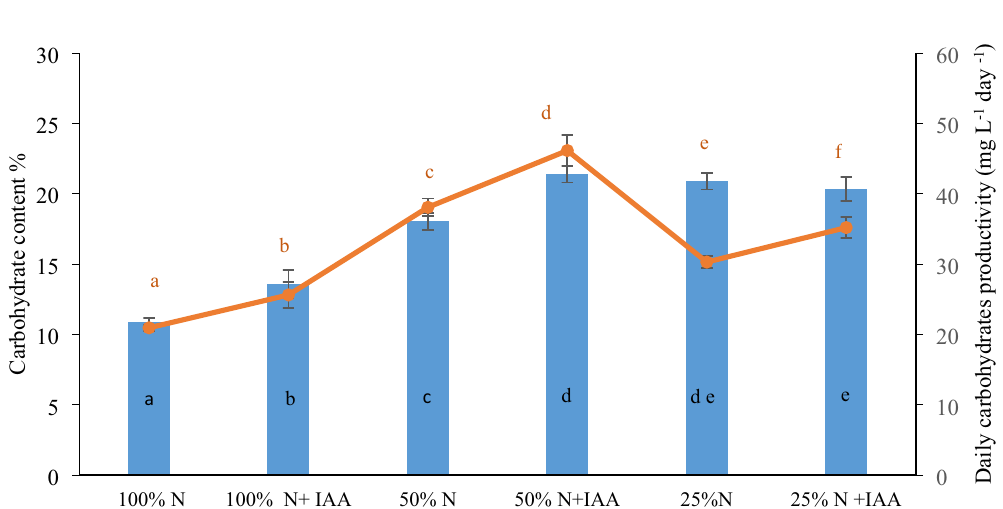
Table 1. The influence of culture conditions on basis growth parameters of Eustigmatos calaminaris . Data are expressed as means ( ± SD), n = 9. Means followed by the same letter are not significantly different; Tukey HSD test, p < 0.05.